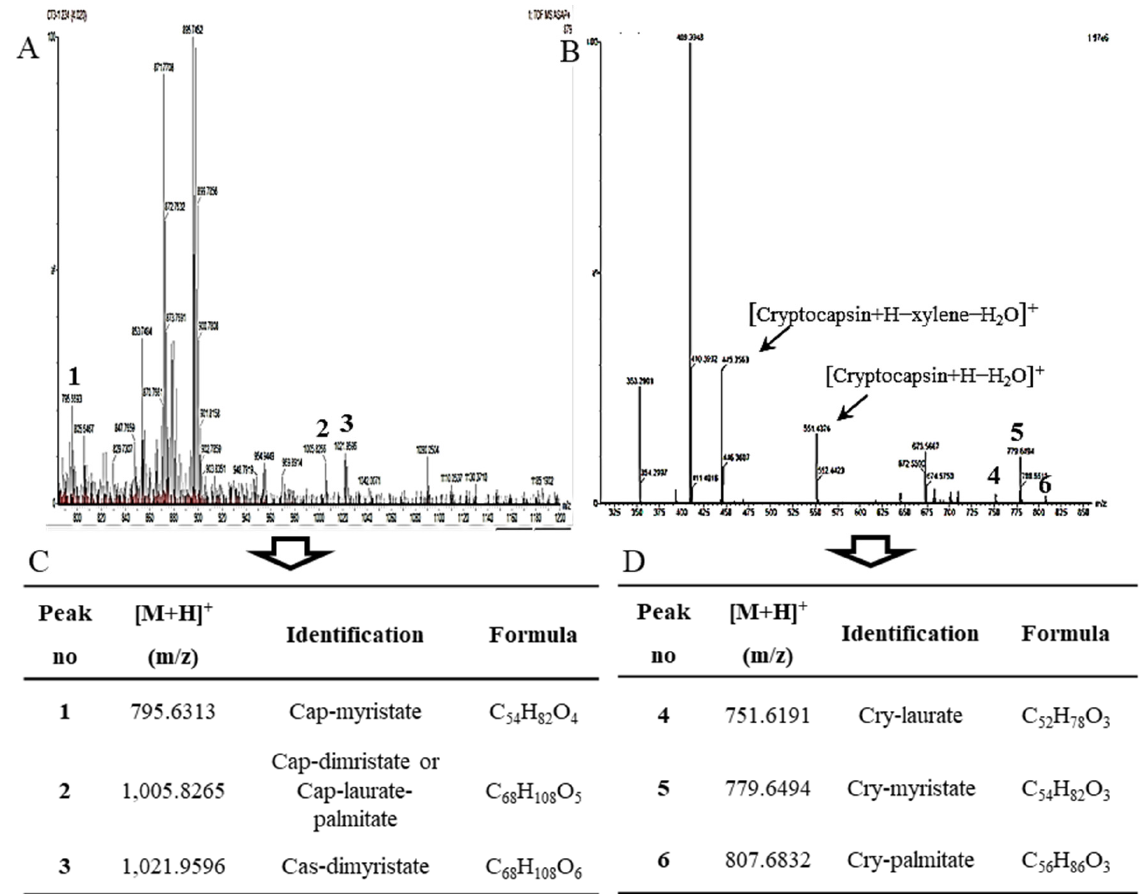
Figure 5. Positive APCI-QTOF-MS analysis and identification of MTE-1 ( A ) and MTE-2 ( B ) fractions isolated from un-saponified extract of MT fruits. Cap, capsanthin; Cas, capsorubin; Cry, cryptocapsin. Tables below were keto-carotenoid esters identified from un-saponified MTE-1 ( C ) and MTE-2 fractions ( D ).